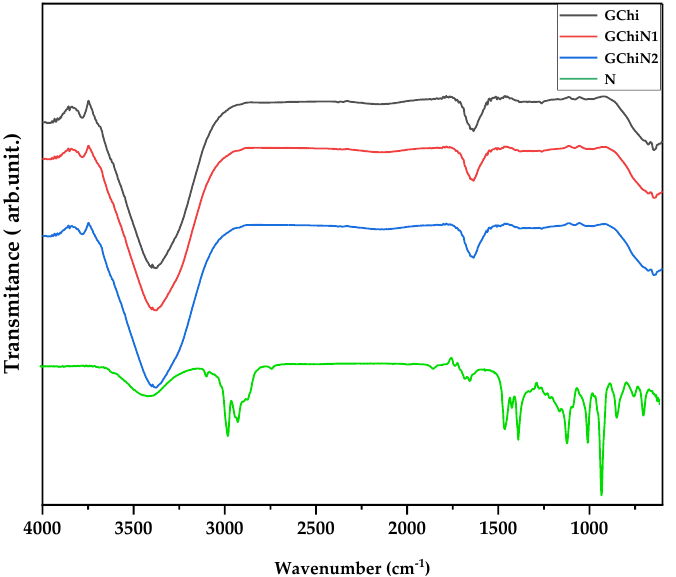
Figure 2. FTIR of chicha hydrogel (GChi), nerolidol (N), chicha hydrogel with 0.01 g mL −1 nerolidol (GChiN1), and chicha hydrogel with 0.02 g mL −1 nerolidol (GChiN2).